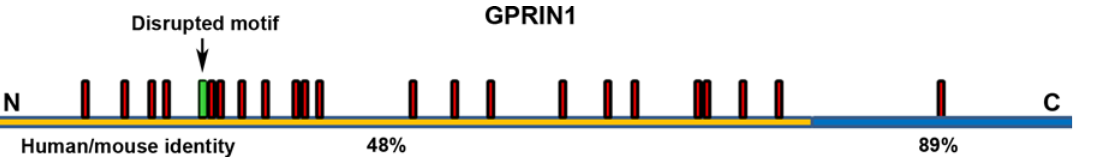
Fig 4. Repeated motifs in GPRIN1. GPRIN1 (formerly known as GRIN1 until the name conflicted with the official gene name of an NMDA glutamate receptor) has sequence characteristics of a relatively unstructured protein, and in human it has 23 copies, of differing fidelity, of a six amino acid motif typified by KEDPGS. The diagram shows the distribution of motifs (red bars) and the location of an abrupt change of the degree of conservation between human and mouse. The less-conserved segment is likely to be relatively unstructured, and the conserved segment is likely to be compactly folded. One motif copy (green bar) is homozygously deleted in the